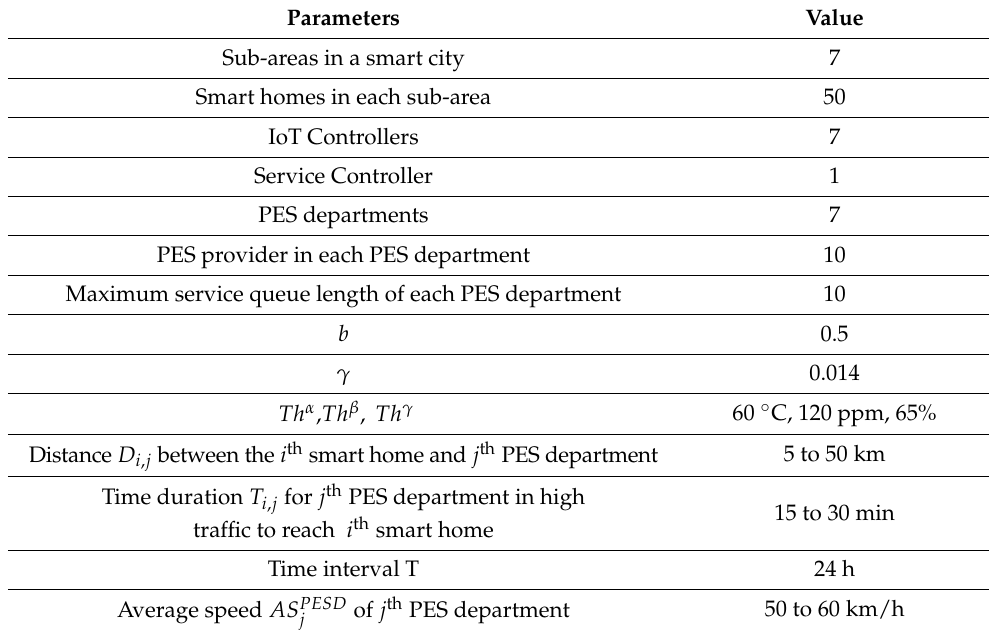
Table 2. Parameter